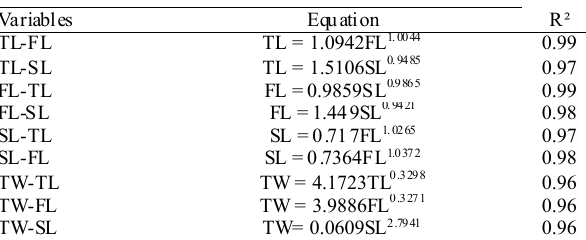
Table 4. Regressions among size variables (TL - Total length, FL - Fork length, SL - Standard length in cm; TW - Total weight in g; n = 204). Size range (TL = 15.5-83.0; FL = 14.5- 79.5, and SL = 12.0-69.5) and weight range (60.0 - 8365.0) of the dog snapper Lutjanus jocu from Abrolhos